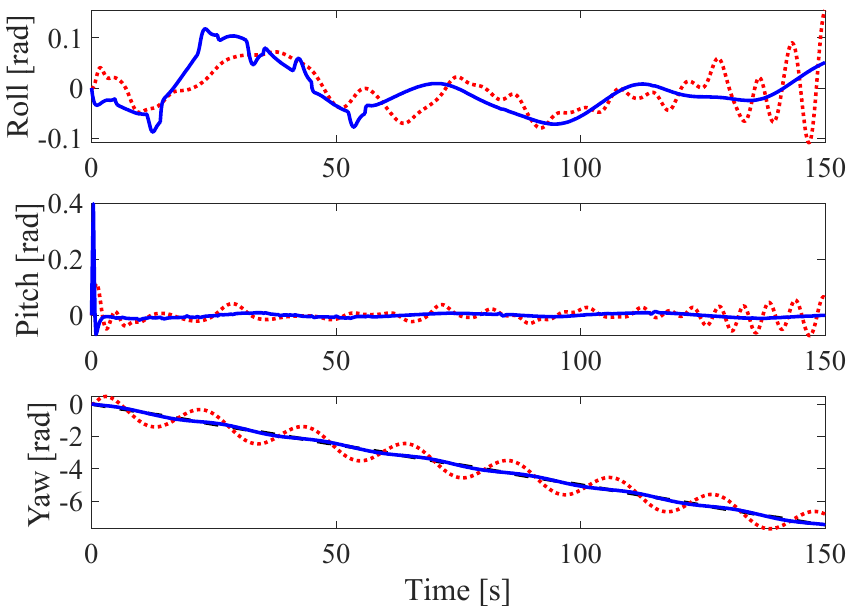
Figure 11. Position control response of two motion control systems in the presence of disturbances. The red dotted line is PID control; the solid blue line is SMC; the reference trajectory of the yaw motion is ϕ d = − 0.05 t .